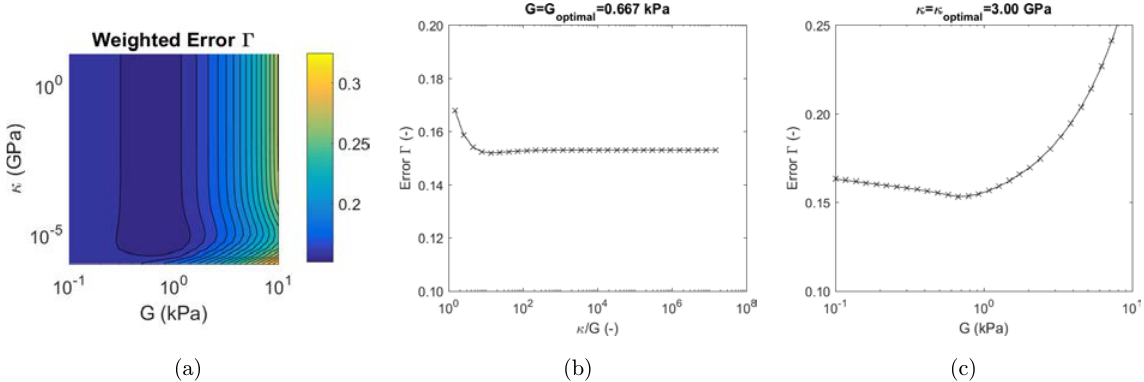
Fig. 6. E®ects of shear modulus G and bulk modulus (cid:8) of the decapsulated porcine lens. (a) Contour plot showing the ¯tting error as a function of G and (cid:8) . Contours are parallel to the (cid:8) -axis for all realistic values of (cid:8) , indicating its precise value is unimportant in determining the model predictions. (b) The error decreases as (cid:8) increases for constant G . Speci¯cally, a ratio (cid:8)= G of greater than 100 yields no appreciable improvement in the solution. (c) At a realistically high value of (cid:8) , the approach yields an optimum for G of